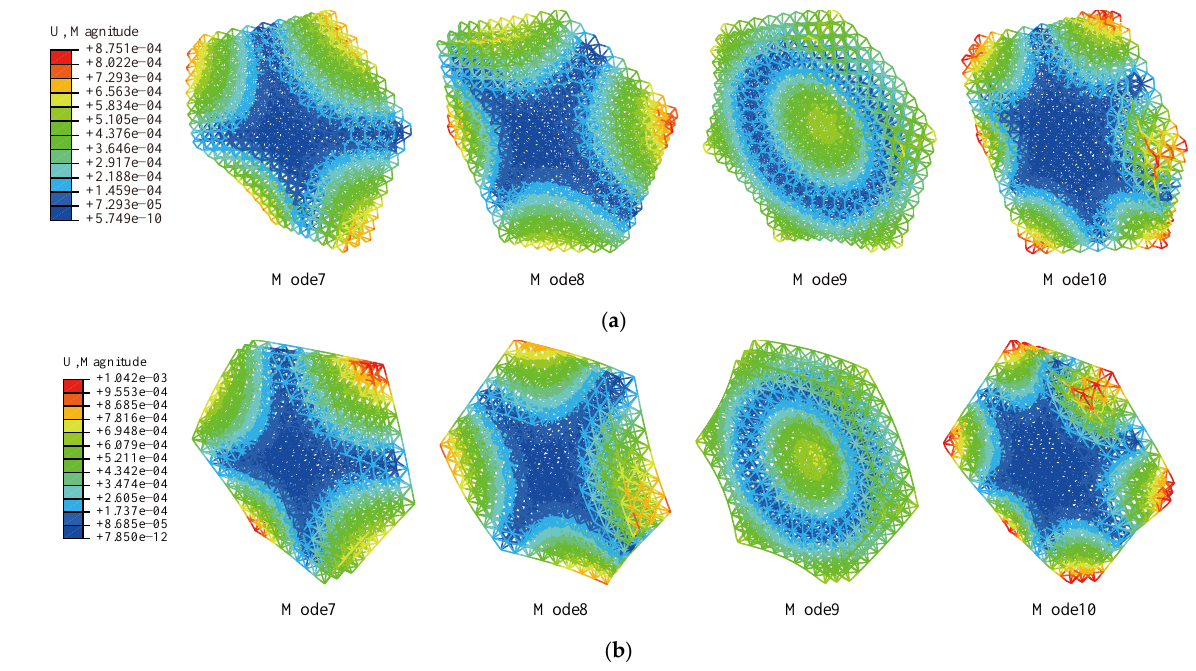
Figure 15. Modal analysis and the mode shapes of a space structure in freedom ( a ) hexagonal hourglass lattice ( b ) triangle hourglass lattice.